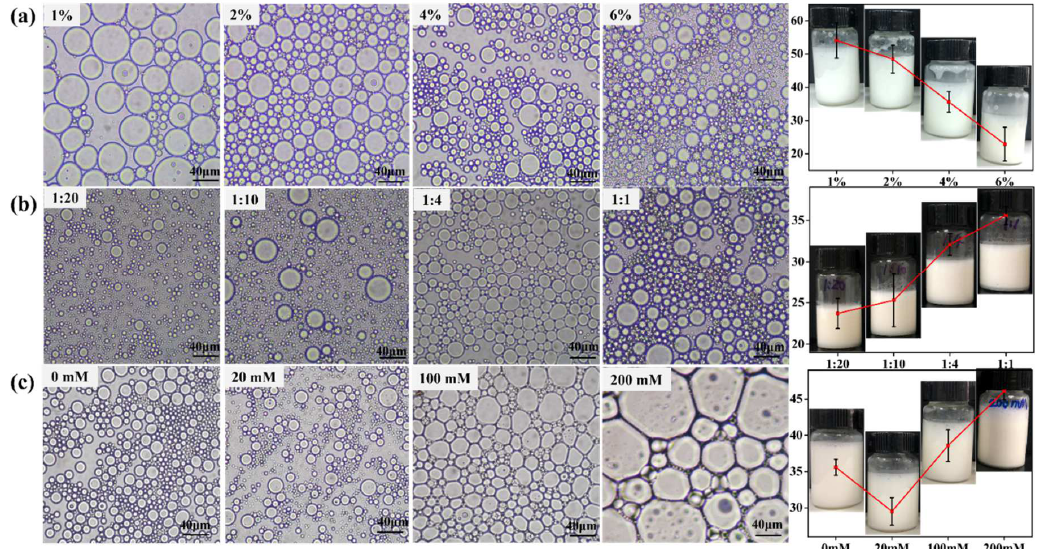
Figure 4. The droplet size (μm) and visual and micromorphologies of OS/β-lg complex stabilized emulsions at different solid concentrations ( a ), oil/water ratios ( b ), and ionic strengths ( c ). Scale bars are 40 μm.